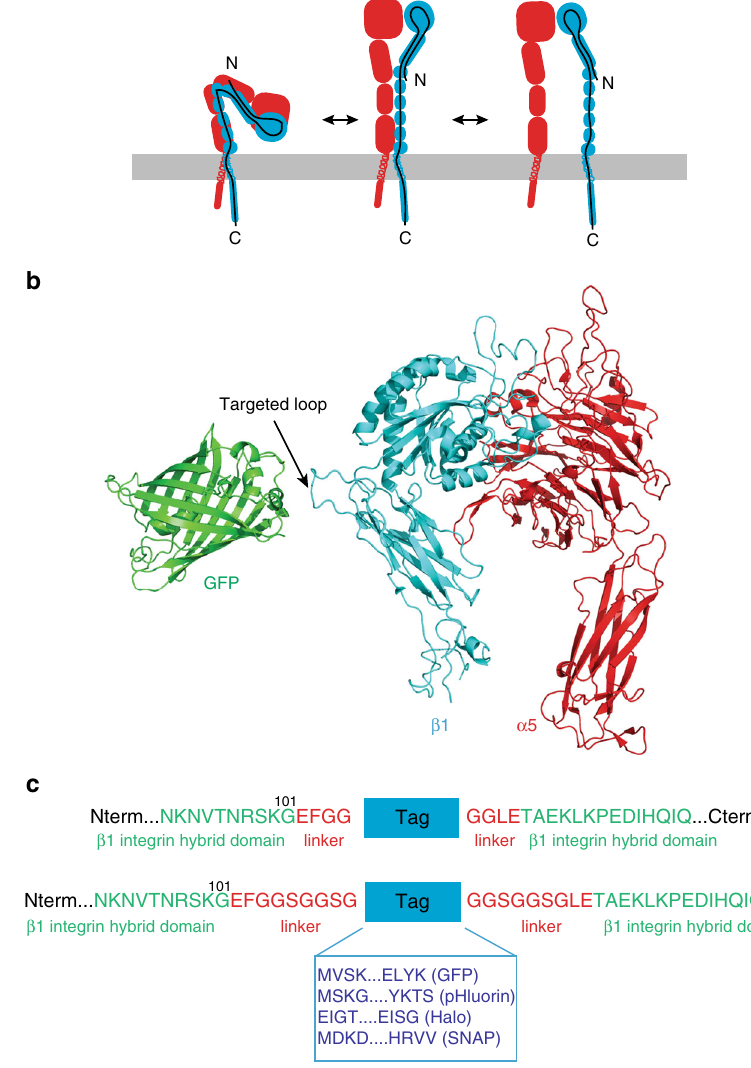
Fig. 1 Design of an ecto-tagged β 1 integrin. a Cartoon of the conformational changes in the integrin heterodimer during integrin activation; α subunit is depicted in red , β subunit in blue , and the black line represents the β subunit polypeptide chain. b Ribbon diagram of the crystal structures of the α 5 β 1 integrin head piece (PDB: 3VI4) and GFP (PDB: 1GFL). The hybrid domain loop into which ecto-tags were inserted is indicated. c Zoom-in on the amino acid sequence of human ecto-tagged β 1 integrins at the tag insertion site. Each ecto-tag (GFP, pHluorin, Halo, and SNAP, in blue , N- and C-terminal sequences speci fi ed) was inserted into the hybrid domain of human β 1 integrin between residues Gly101 and Tyr102 (in green ). Linkers of 4 or 9 amino acids (in red ) were added on each side of the tag to facilitate cloning and provide fl